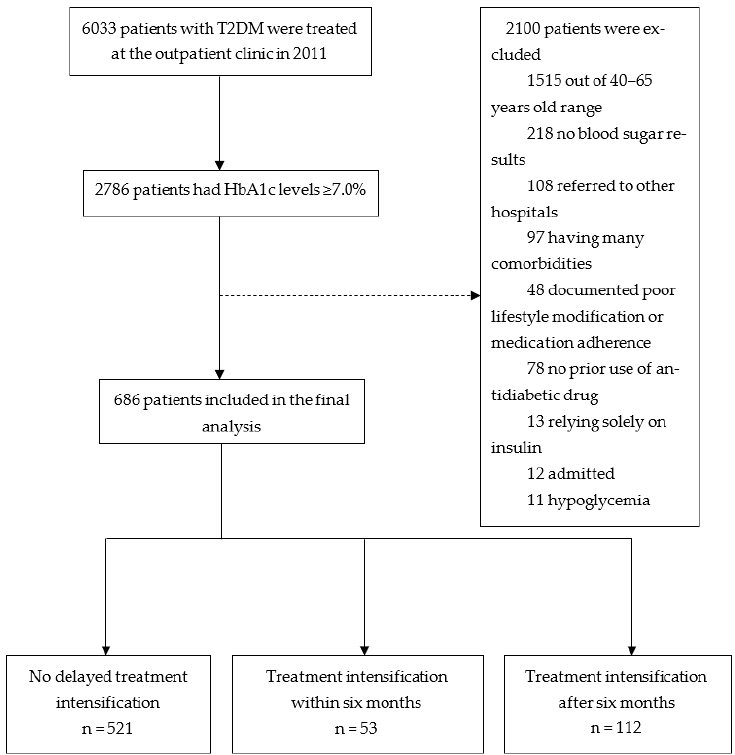
Figure 2. Patient flow diagram.